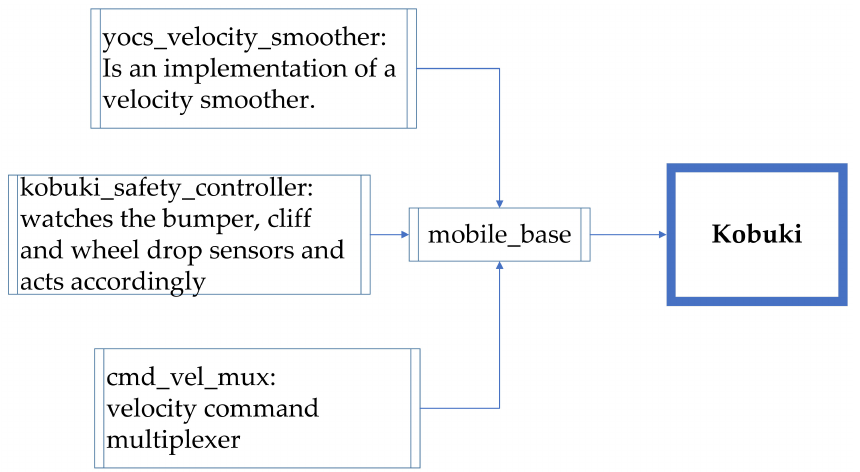
Figure 7. Kobuki block diagram.